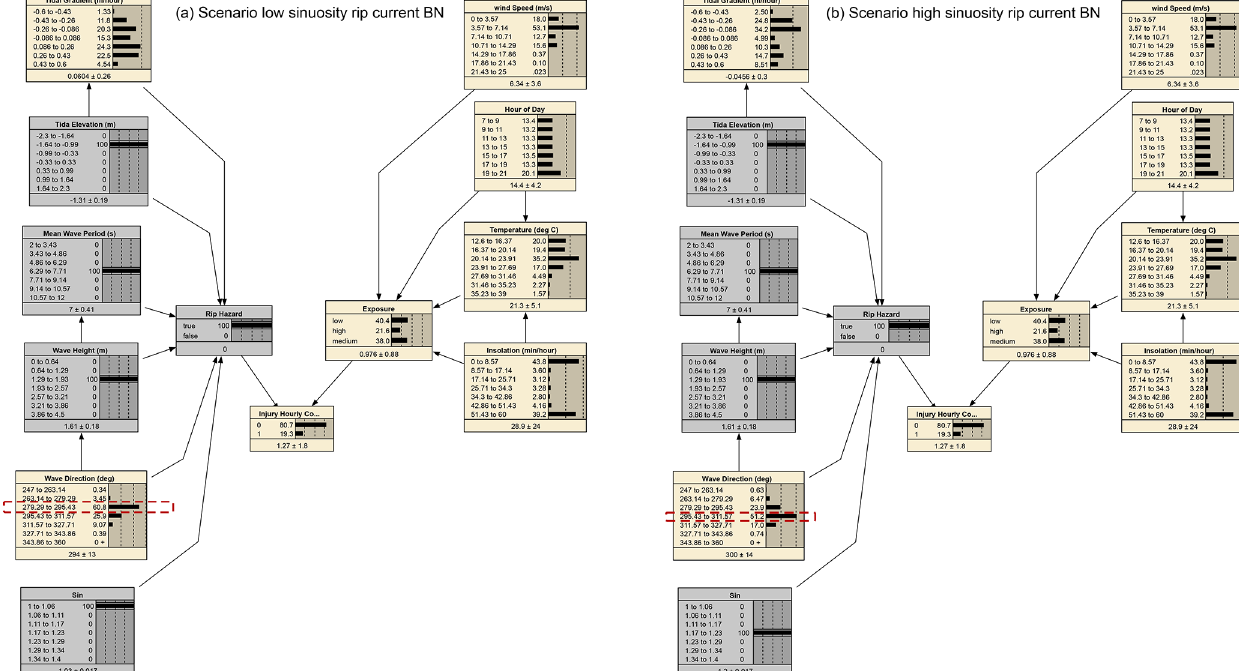
Figure 12. (a) Scenario with low sinuosity resulting in more shore-normal wave direction (around 279 ◦ ) with the rip-current BN. (b) Scenario with medium sinuosity resulting in more obliquely incident (NW) wave conditions with the rip-current